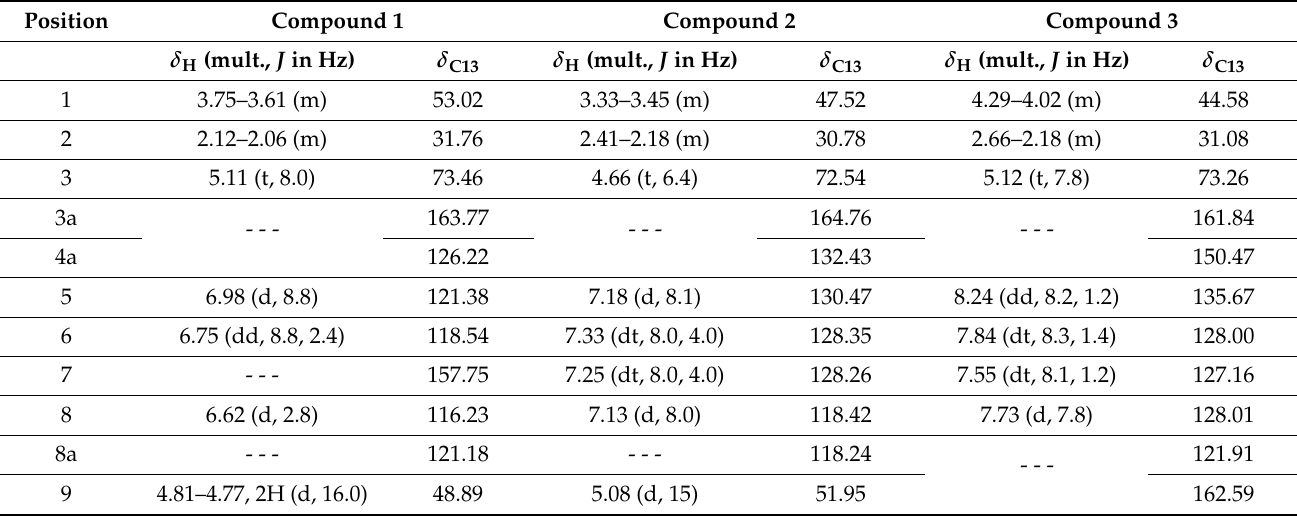
Table 5. 1 H and 13 C-NMR spectral data for compounds 1 – 3 in CD 3